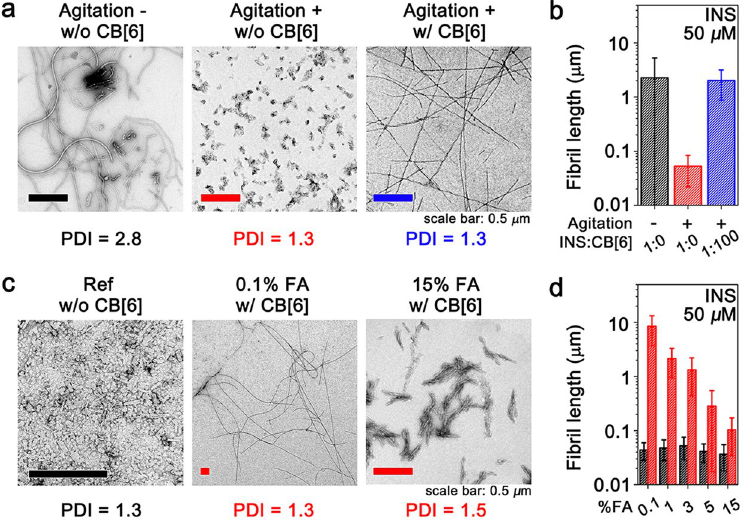
Figure 2. Modulation of INS fibrils by CB[6]. ( a ) TEM images of INS fibrils formed in 5% FA (INS = 50 μ M and CB[6] = 5 mM). ( b ) Average lengths of INS fibrils (lengths and PDIs are available in Supplementary Table S2; fibril length distributions are presented in Supplementary Fig. S8). ( c ) TEM images of INS fibrils in variable %FA (INS = 50 μ M, CB[6] = 500 μ M). Ref is the representative image of INS fibrils formed without CB[6]. All fibrils were prepared with agitation at 200 rpm. ( d ) Average fibril lengths determined from the TEM images in ( c ) (fibril lengths and PDIs are available in Supplementary Table